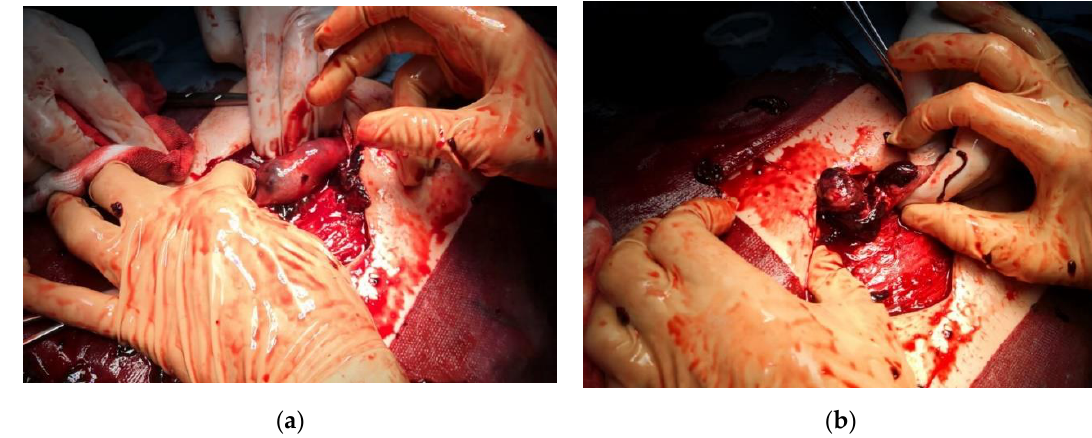
Figure 2. Intraoperative aspects: ( a ) Direct visualization of the ruptured fallopian tube during laparotomy; ( b ) unilateral salpingectomy was performed, and overall blood loss was 1500 mL.